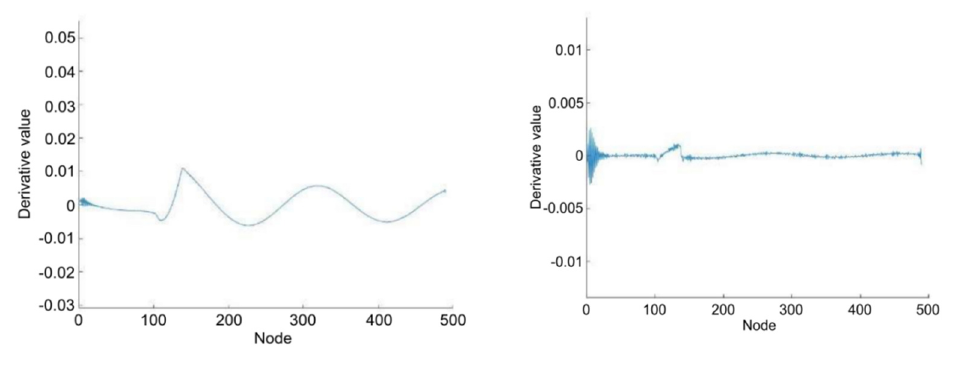
Figure 26. First-order and second-order derivatives of the differences of the first five orders of modes under Conditions 1 and 3.